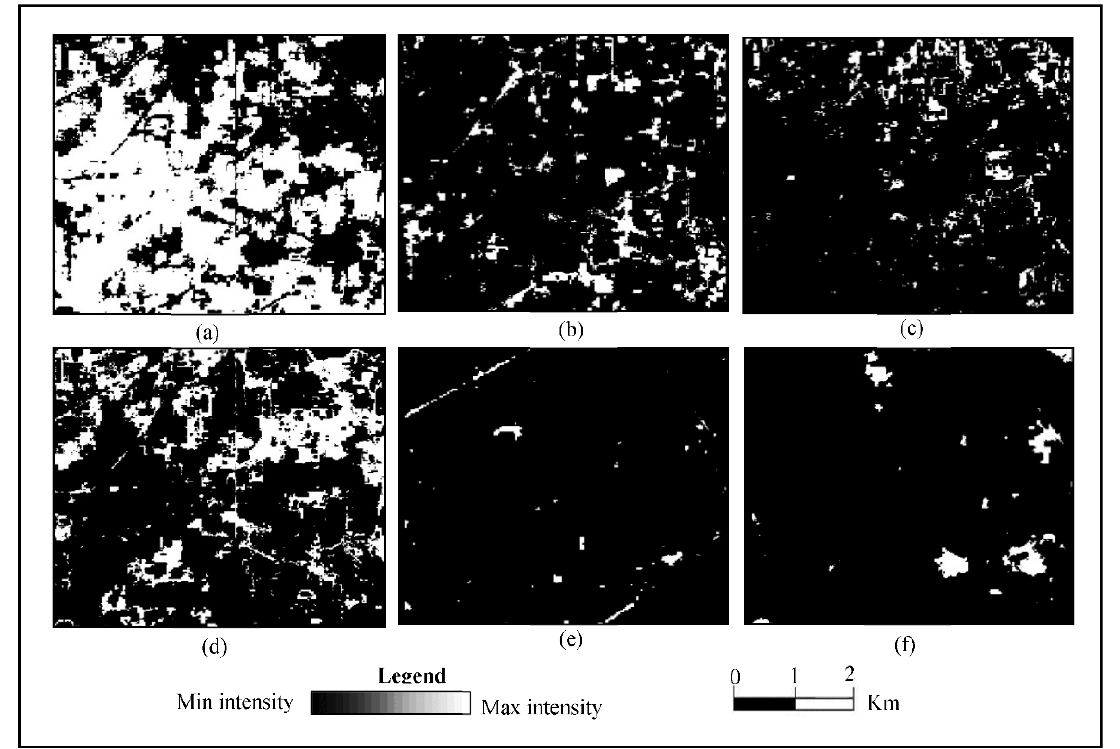
Figure 3. Activation maps generated from deep learning classification for individual class category: ( a ) Wheat; ( b ) Berseem; ( c ) Mustard; ( d ) Other vegetation; ( e ) Water; and ( f ) Buildup area. Figure 4 represents the visual interpretation of classified outputs generated from U- the various parameters have been computed, i.e., producer’s accuracy (PA), user’s accuracy (UA), overall accuracy (OA), kappa coefficient (k), Reference Total (RT); Classified Total (CT); and Number of correct (NC). Table 2 represents the accuracy assessment computed from U-Net-based deep learning and RF-based machine learning. It was observed that U-Net-based deep learning performed better (OA = 97.8% and k = 0.9691), as compared to RF-based machine learning (OA = 96.8% and k = 0.9691).